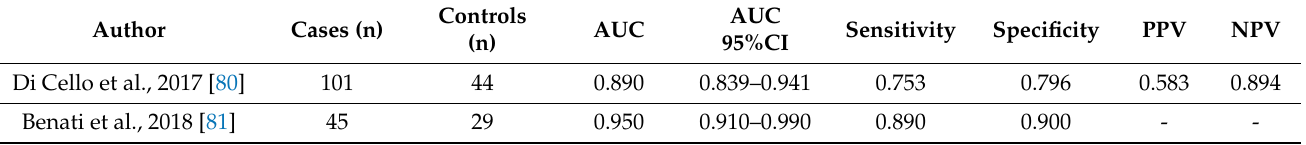
Table 14. Summary table of the performance of